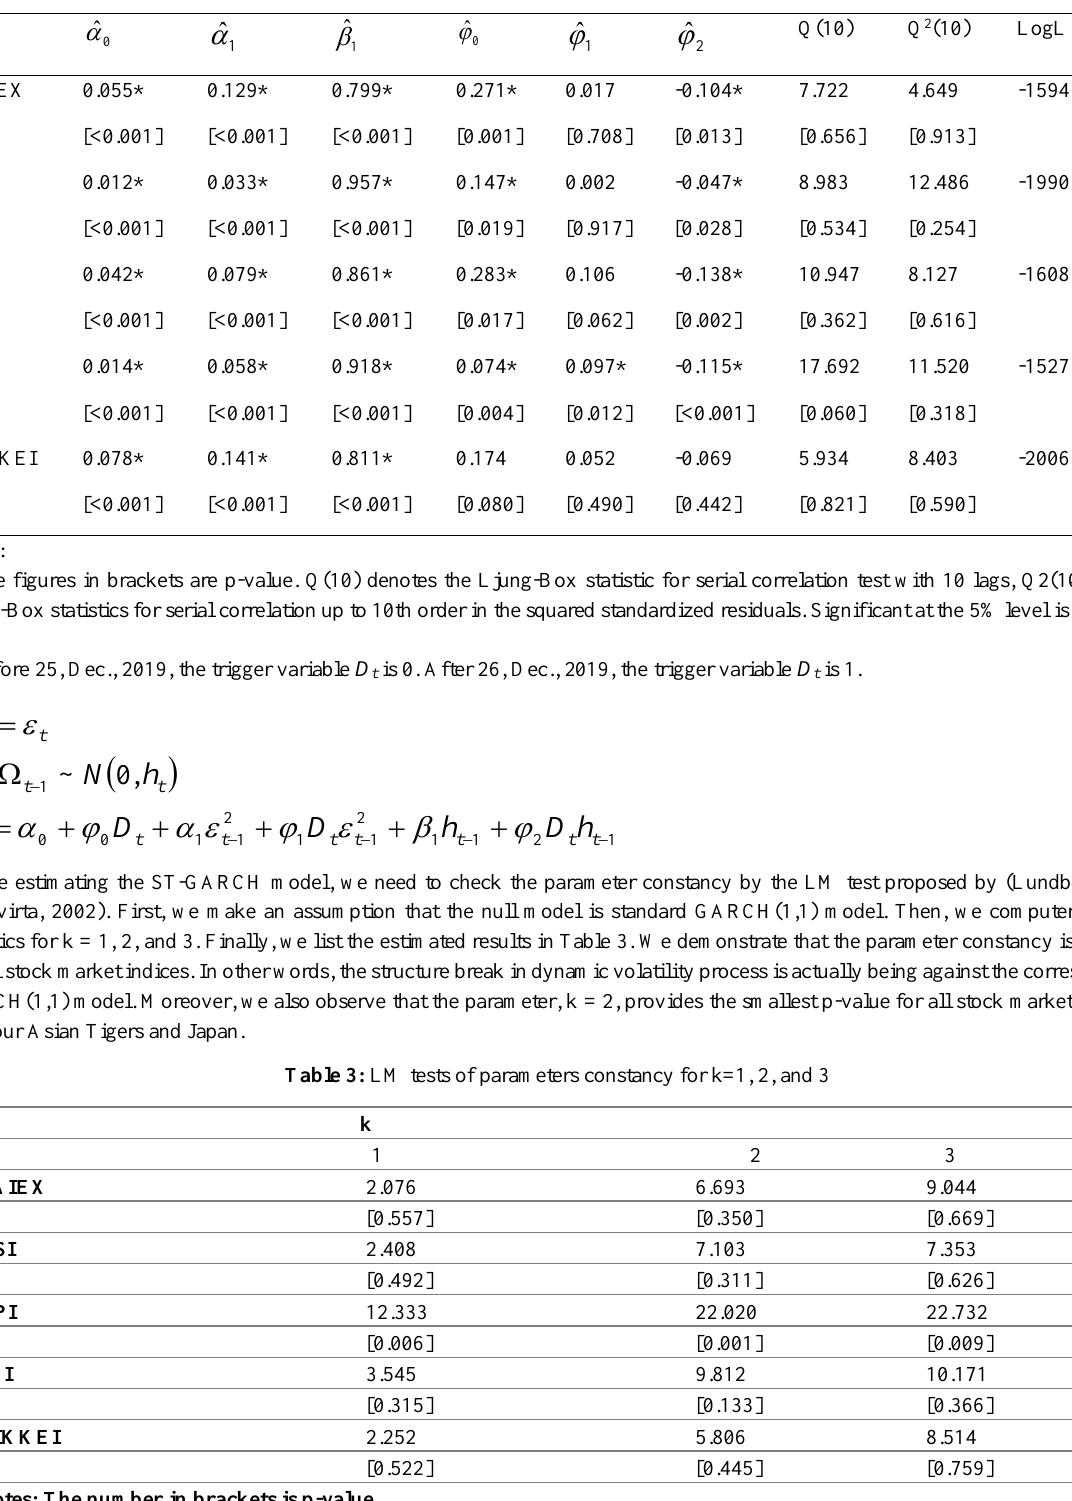
Table 2: The modified GARCH(1,1) model with exogenous trigger variables estimation